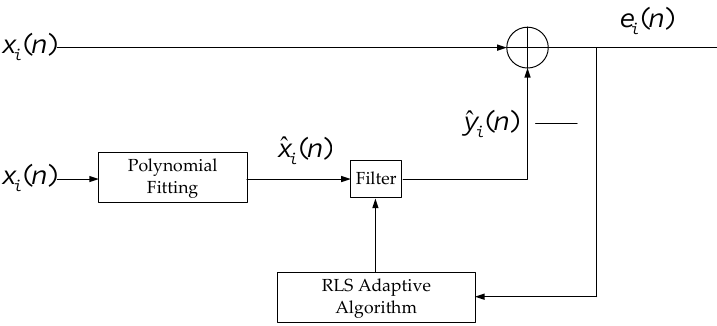
Figure 3. Block diagram of the RBM signal elimination: x i ( n ) is the motion signal of the human body; RLS: recursive least squares; x 1 ( n ) is the motion signal of the chest; x 2 ( n ) is the motion signal of the abdomen.